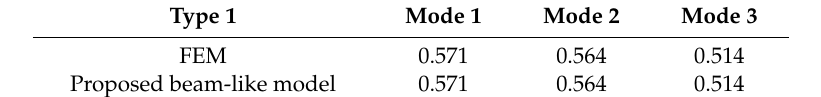
Table 2. Modal period comparison.